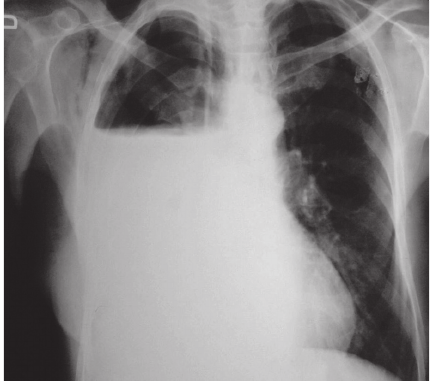
Figure 2: Chest X-ray shows hydroaeric level in the right hemitho- rax, suggesting state after